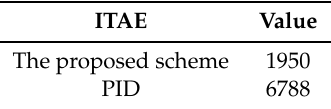
Table 2. ITAE index under strong